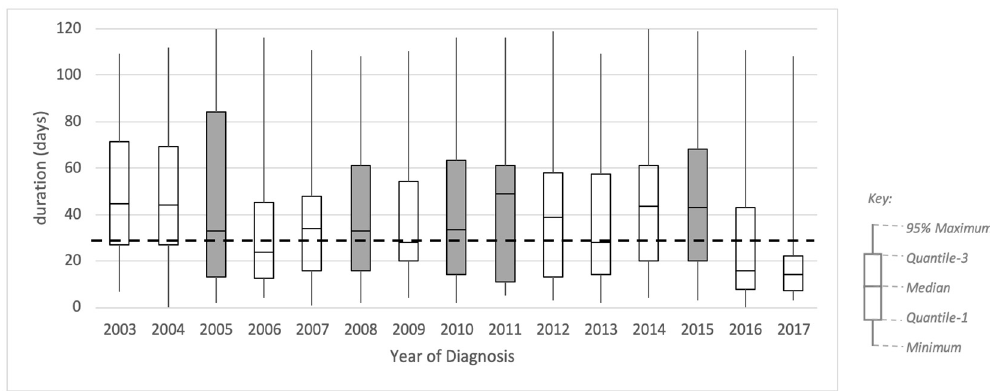
Figure 5. Boxplot of number of days from GP referral to diagnosis by year of diagnosis. Dashed line shows target duration (28 days). The shaded boxes show the periods where change might have occurred.